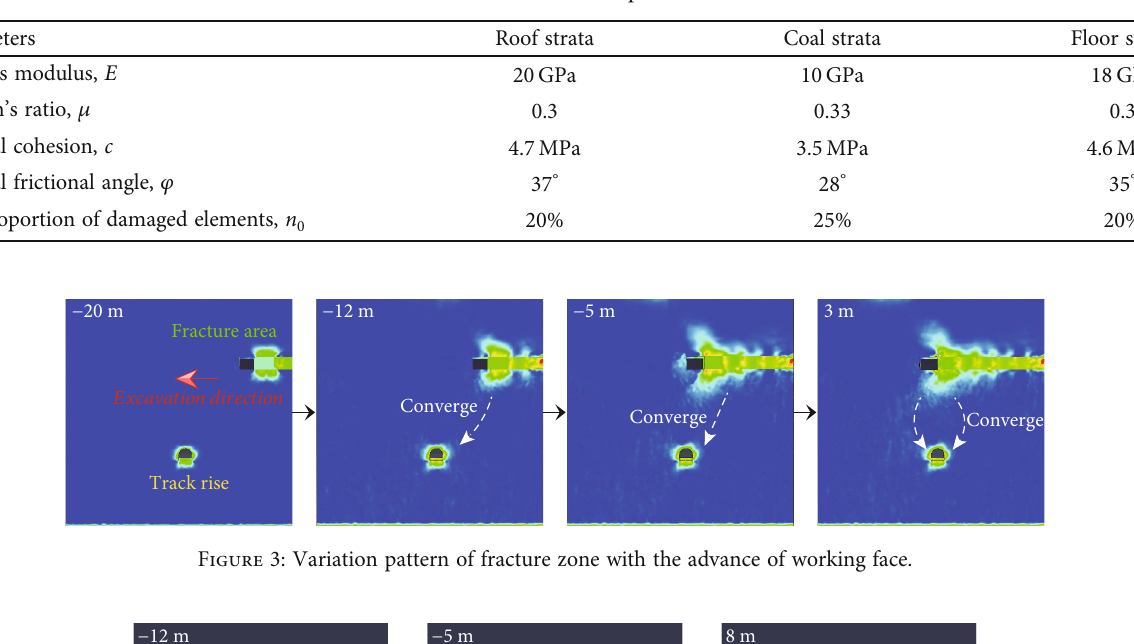
Table 1: Numerical model parameters.